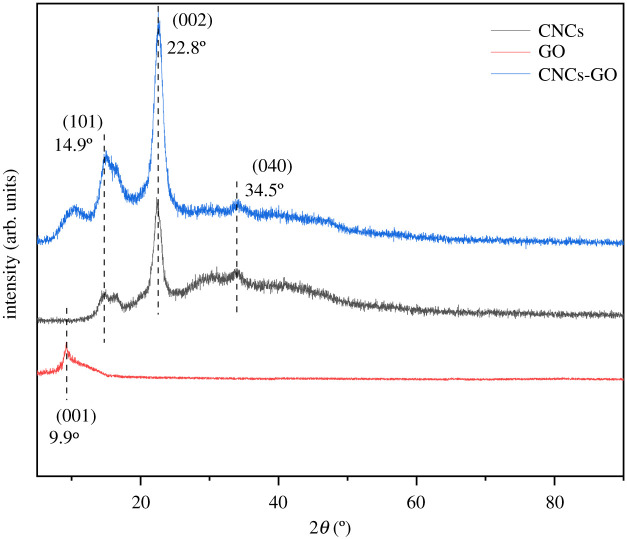
X-ray diffraction patterns of CNCs, GO and CNCs-GO.